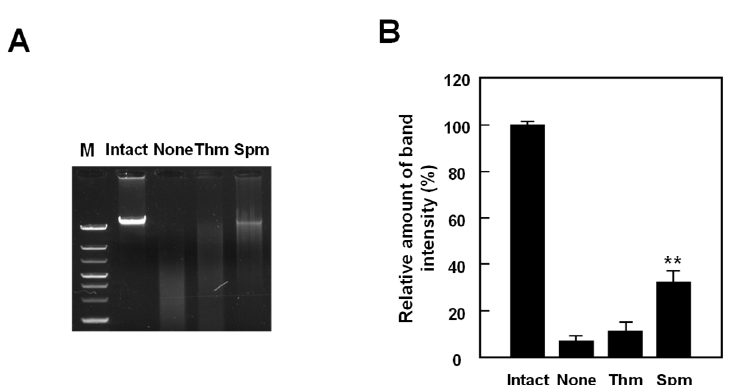
Figure 3. DSBs of T. thermophilus genome at high pH. ( A , B ) Degree of protection of wild-type genome against DSBs by thermine (Thm) and spermine (Spm). Experiments were conducted in the presence of 100 µ M polyamines. The results are shown as mean ± standard errors of triplicate determinations. Student’s t -test was performed for the value of obtained in presence of polyamines versus its absence. **, p <